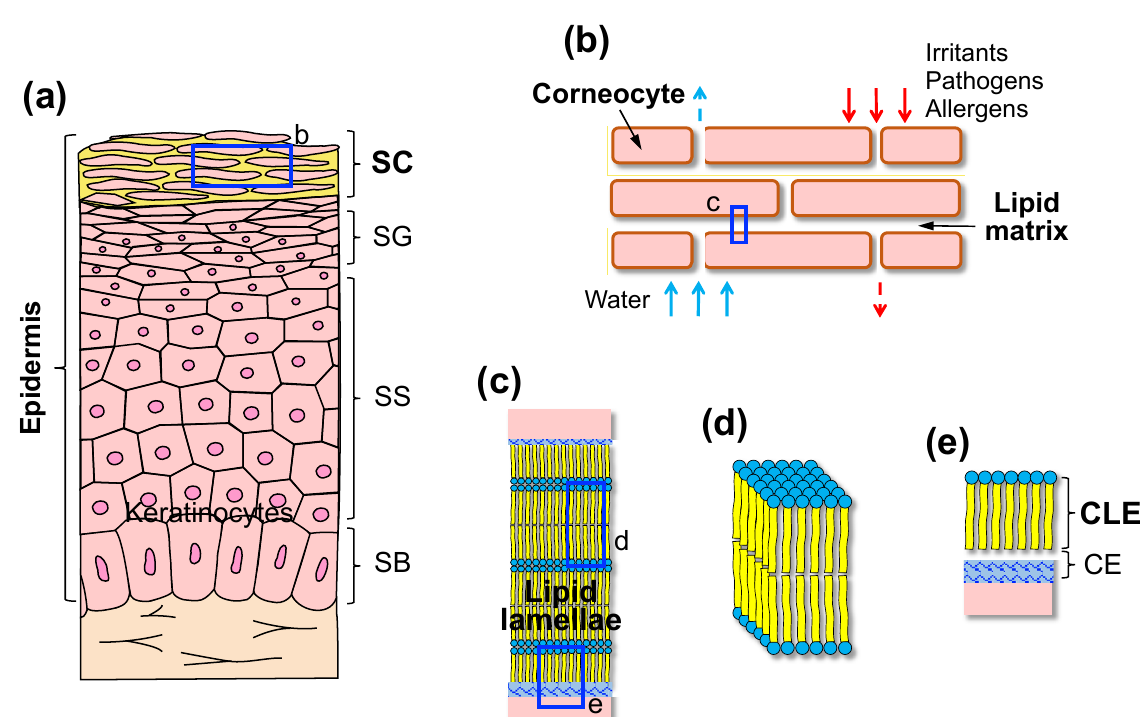
Figure 1. The stratum corneum (SC) as a permeability barrier. ( a ) The structure of the epidermis. The epidermis is composed of four different layers: the SC, the stratum granulosum (SG), the stratum spinosum (SS), and the stratum basale (SB). ( b ) The SC is composed of corneocytes embedded in a lipid matrix and functions as a permeability barrier. ( c ) The intercellular lipids are arranged in multiple bilayers (lamellae). ( d ) Within the lipid lamellae, lipid head groups assume a very dense, ordered orthorhombic lateral organization. ( e ) Lipids bind covalently to the glutamate residues of the cornified envelope (CE) proteins, such as involucrin and loricrin, forming a lipid monolayer called the cornified lipid envelope (CLE). Each letter-labelled blue square refers to a corresponding magnified image.